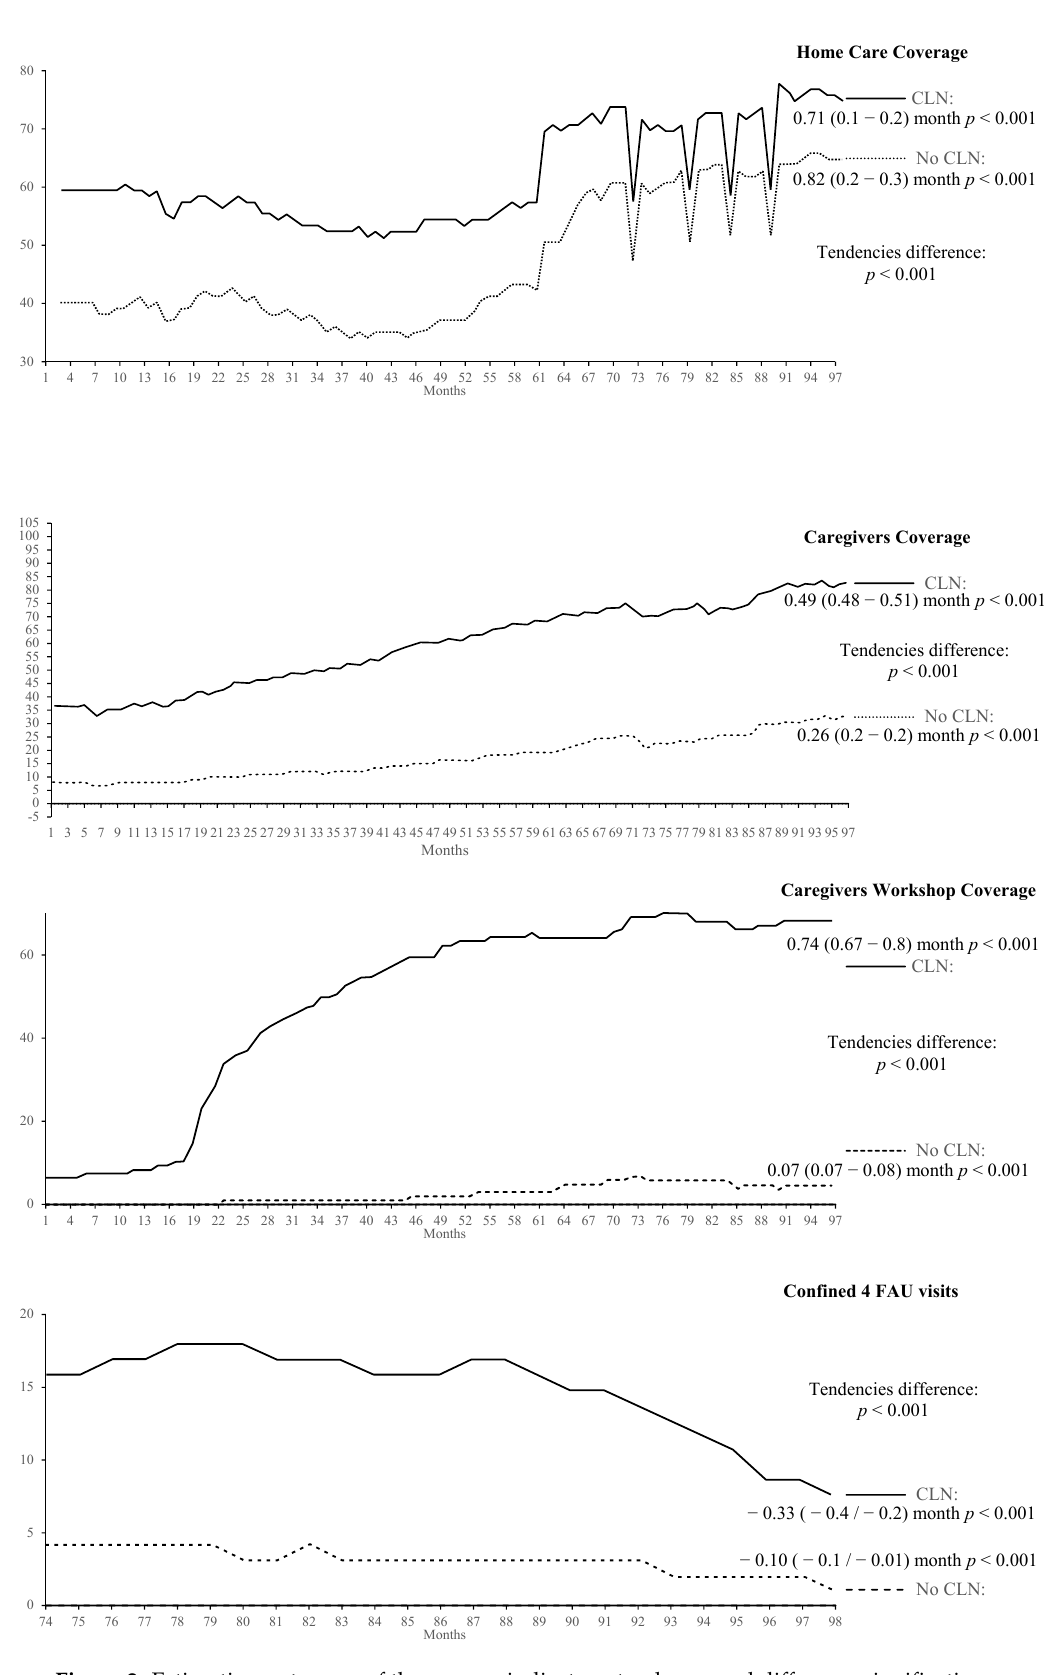
Figure 2. Estimation outcomes of the process indicators, tendency, and di ff erence